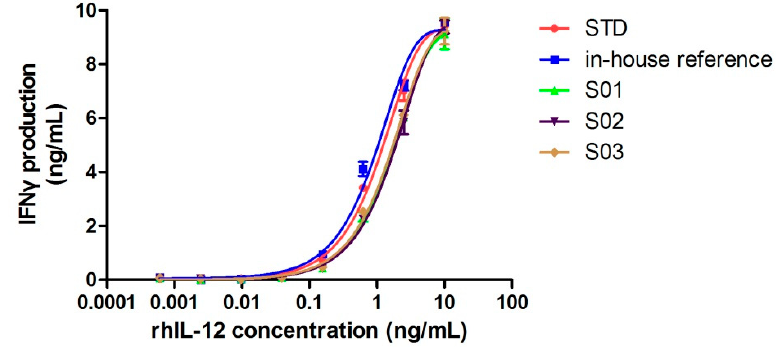
Table 3. The results of protein content, biological activity and specific activity.